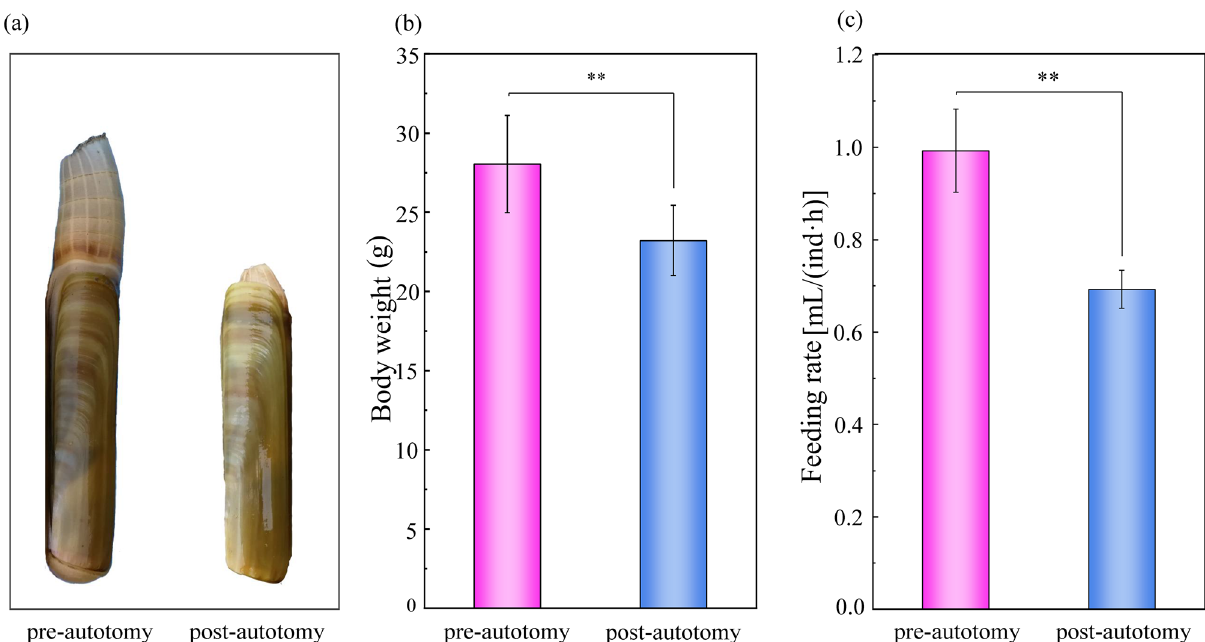
Figure 1. Effect of siphonal autotomy on body weight and feeding rate in Solen grandis . Data are expressed as mean ± SD. The asterisk (**) indicates significant difference at P <